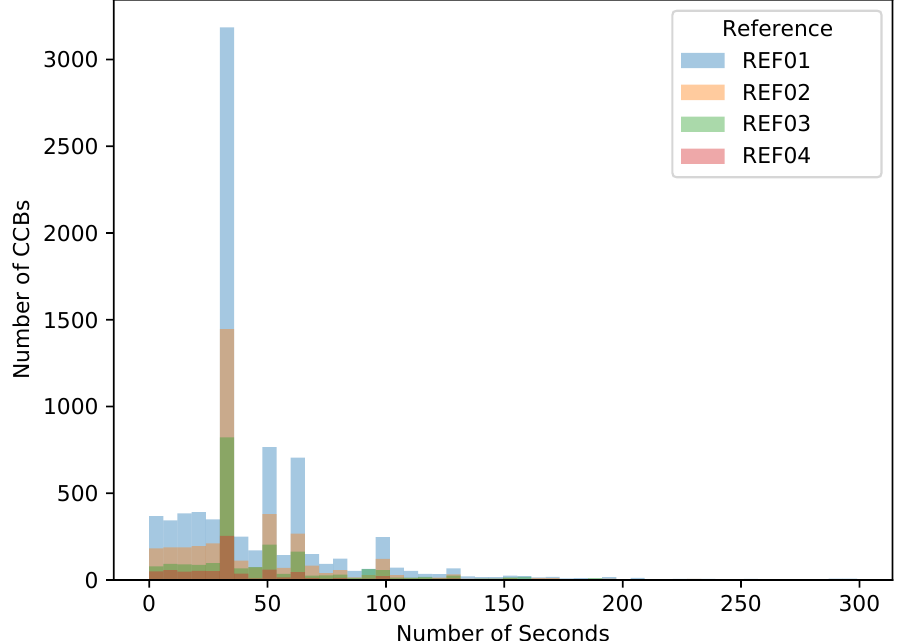
Figure 6. Standardisation for process duration at robotised inspection depending on the